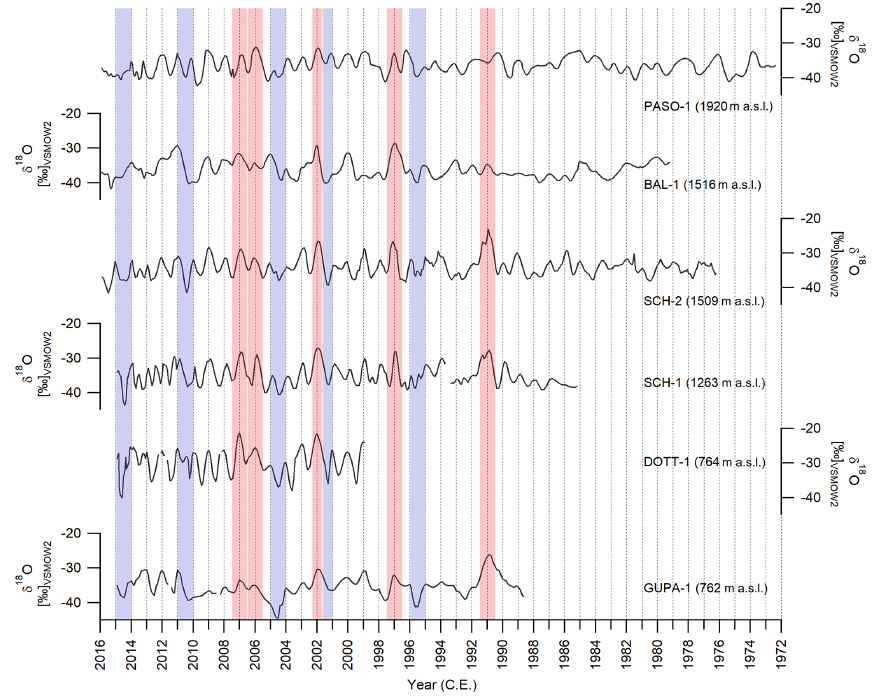
Figure 7. Profiles of the stable water isotope composition ( δ 18 O) of the six firn cores from UG with respect to time. Years with prominent maxima and minima in δ 18 O time series – although not visible in all cores – are highlighted by red and blue shading, respectively. The peak in summer 2002 is the only maximum found in all